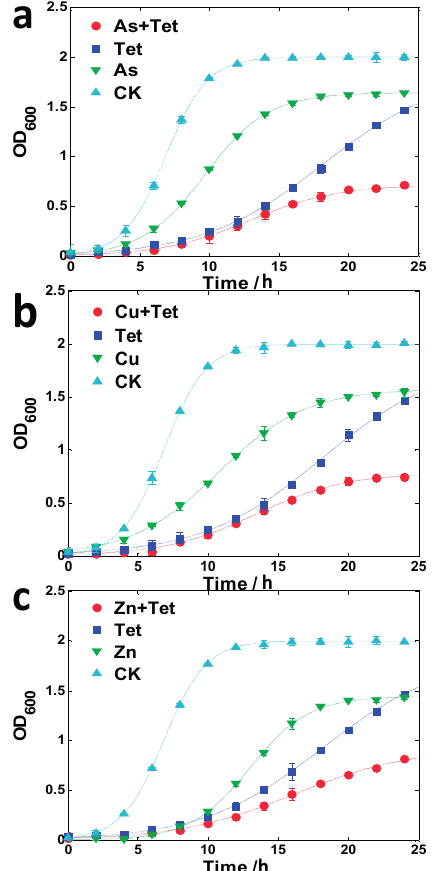
Figure 4. ( a ) Growth curve of Pseudomonas oryzihabitans with 2 mM arsenate (As) and/or 2 μ M tetracycline (Tet) treatment; ( b ) Growth curve of P. oryzihabitans with 4 mM copper (Cu) and/or 2 μ M Tet treatment; ( c ) Growth curve of P. oryzihabitans with 5 mM zinc (Zn) and/or 2 μ M Tet treatment. Each point is presented as mean ± SD ( n = 3). Growth curves are fitted by logistic